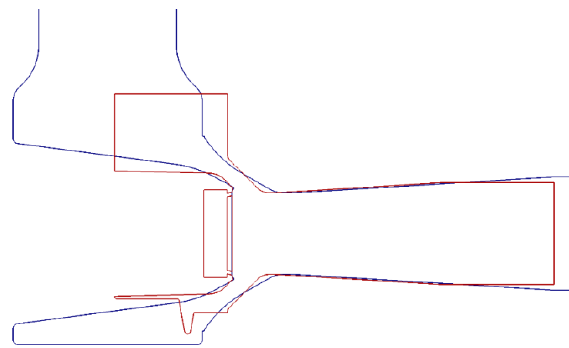
Fig. 3. Relative comparison of cross-section through the valve chamber, a typical control valve (blue) and a compact control valve (red) [12] .